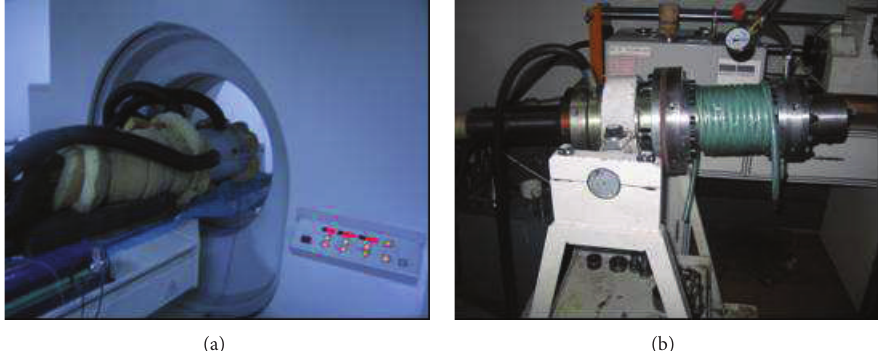
Figure 3: (a) The computerized tomography Siemens SOMATOM-PLUS X-ray and (b) the loading equipment matching of computerized tomography for frozen soil (after reference [15]).